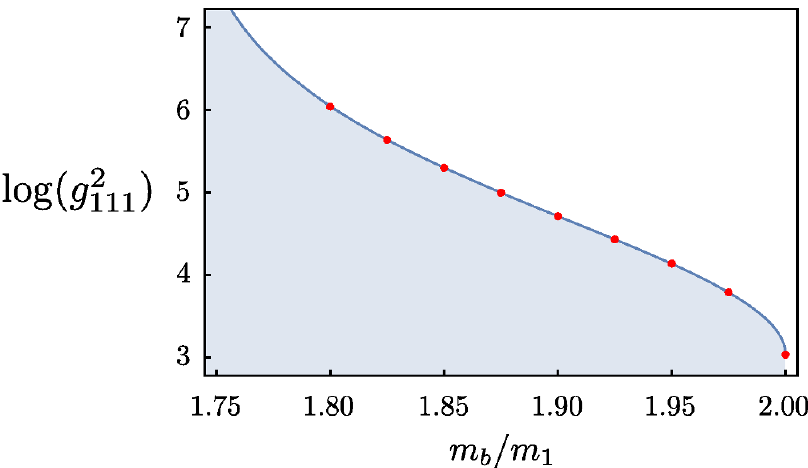
Figure 9 . Upper bound on the (cid:13)at space self-coupling g 111 as a function of the mass ratio m b =m 1 . The dots are our numerical results obtained by extrapolation to in(cid:12)nite derivatives and in(cid:12)nite (cid:1) 1 . The solid blue curve shows the same quantities for the exact S-matrix explained in the main